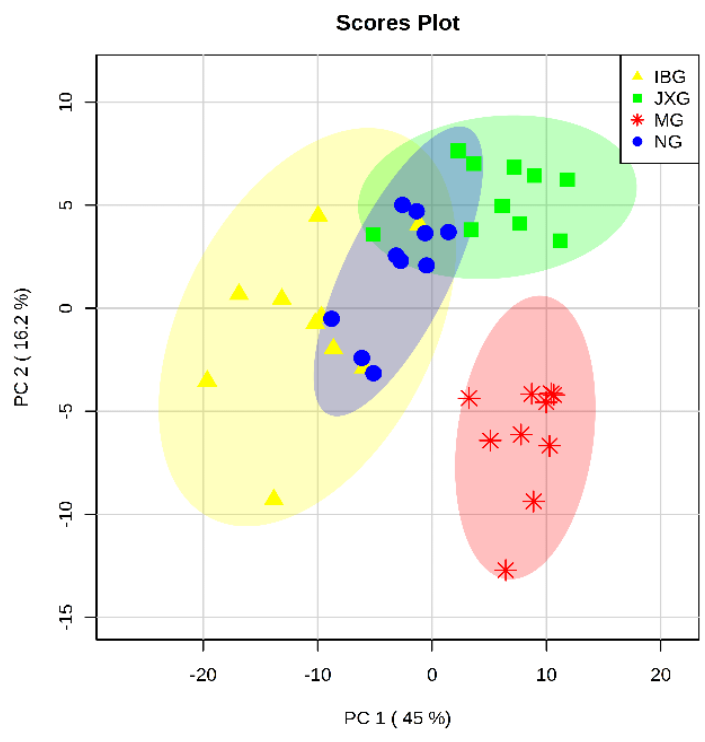
Figure 3. PCA scores scatter plot of brain metabolites.